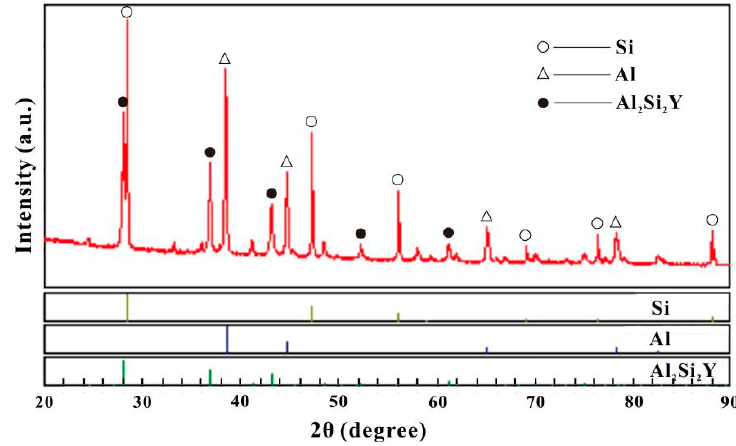
Figure 4. XRD pattern of alloy sample No. 32.